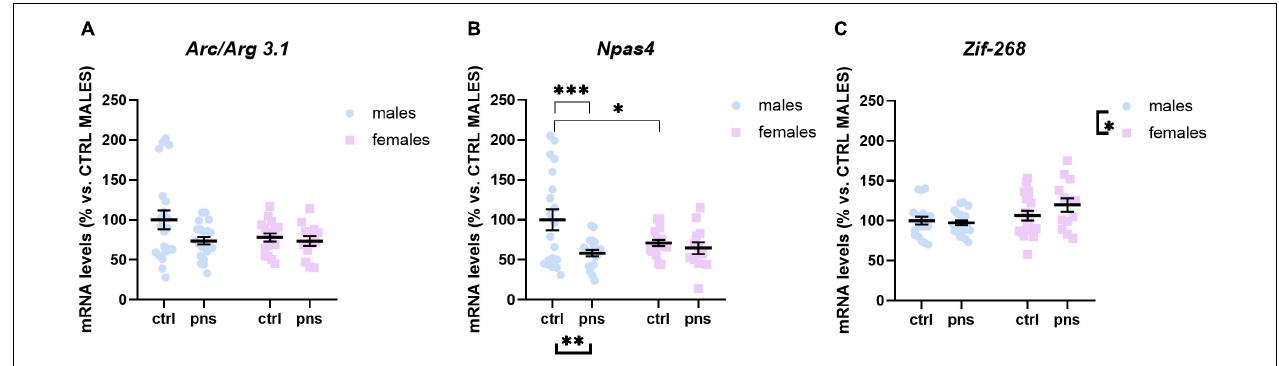
FIGURE 4 | Analysis of ( A ) Arc/Arg 3.1 , ( B ) Npas4 , and ( C ) Zif268 mRNA levels in the prefrontal cortex of males and females exposed to prenatal stress. Data are expressed as a percentage of control males not exposed to stress (set at 100%) and represent the mean ± SEM of at least 10 independent determinations. Data information: symbols represent individual data. ∗ p < 0.05; ∗∗ p < 0.01; ∗∗∗ p < 0.001 vs. control males (two-way ANOVA with Bonferroni’s multiple-comparison test).